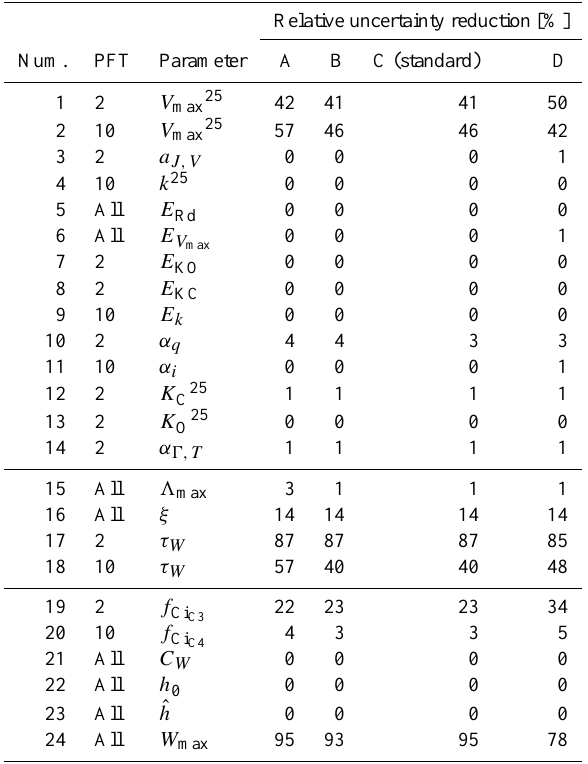
Table 5. Uncertainty reduction for model parameters for the sensi- tivity experiments on the effect by prior W max